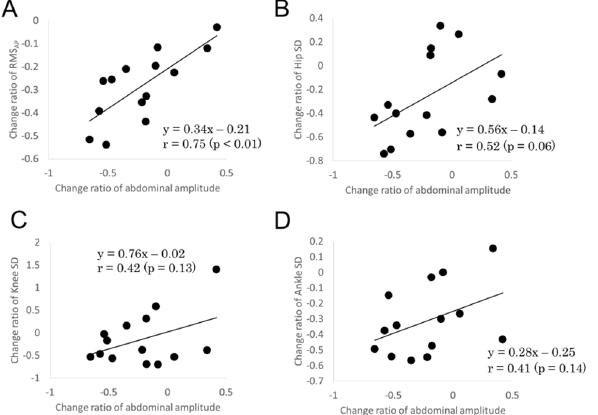
Fig 2. Relation between the ratio changes in breathing amplitude and the ratio changes in (A) the root mean square (RMS) of COP displacement in the anterior–posterior (AP) direction, (B) the standard deviation (SD) of hip movement, (C) the SD of knee movement, and (D) the SD of ankle